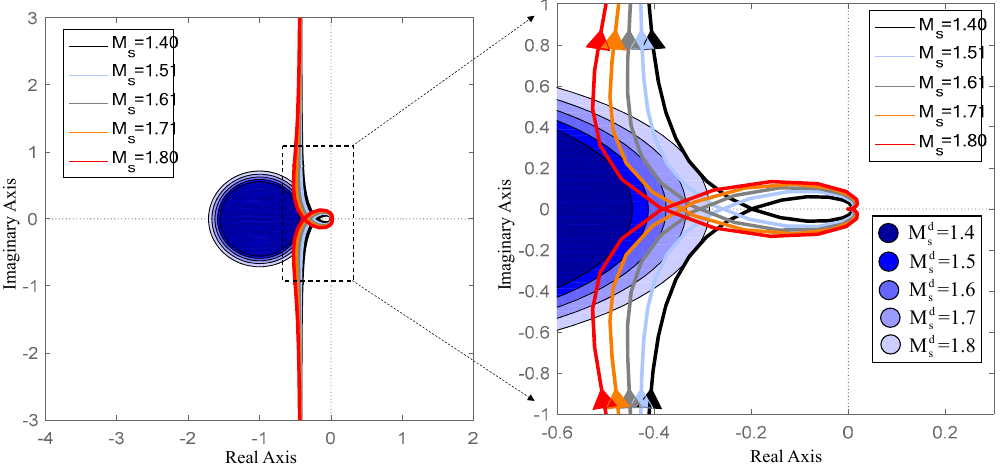
Figure 6. Achieved maximum sensitivity M s and designed maximum sensitivity M d s